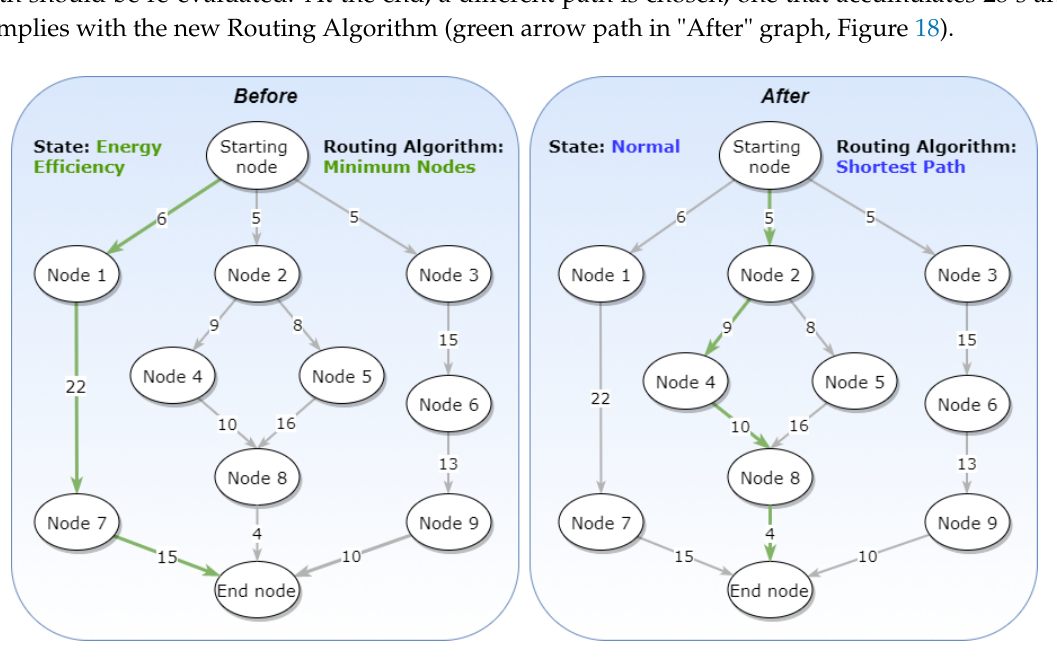
Figure 18. Routing Algorithm Use